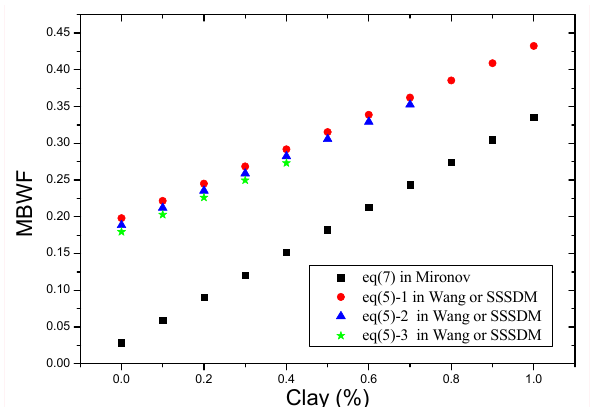
Figure 2. Maximum bound water fraction (MBWF) versus clay percentage. Legend notes: eq (5) and eq (7) indicate that the MBWF is computed by Equation (5) or Equation (7), respectively, and: 1, a sand fraction of 0; 2, a sand fraction of 30%; and 3, a sand fraction of 60%.